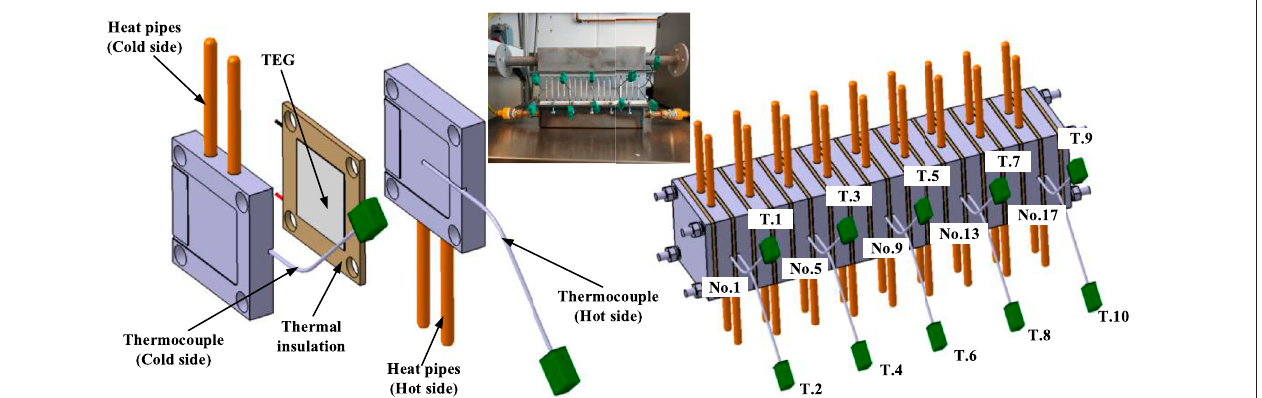
FIGURE 2 | Temperature sample points